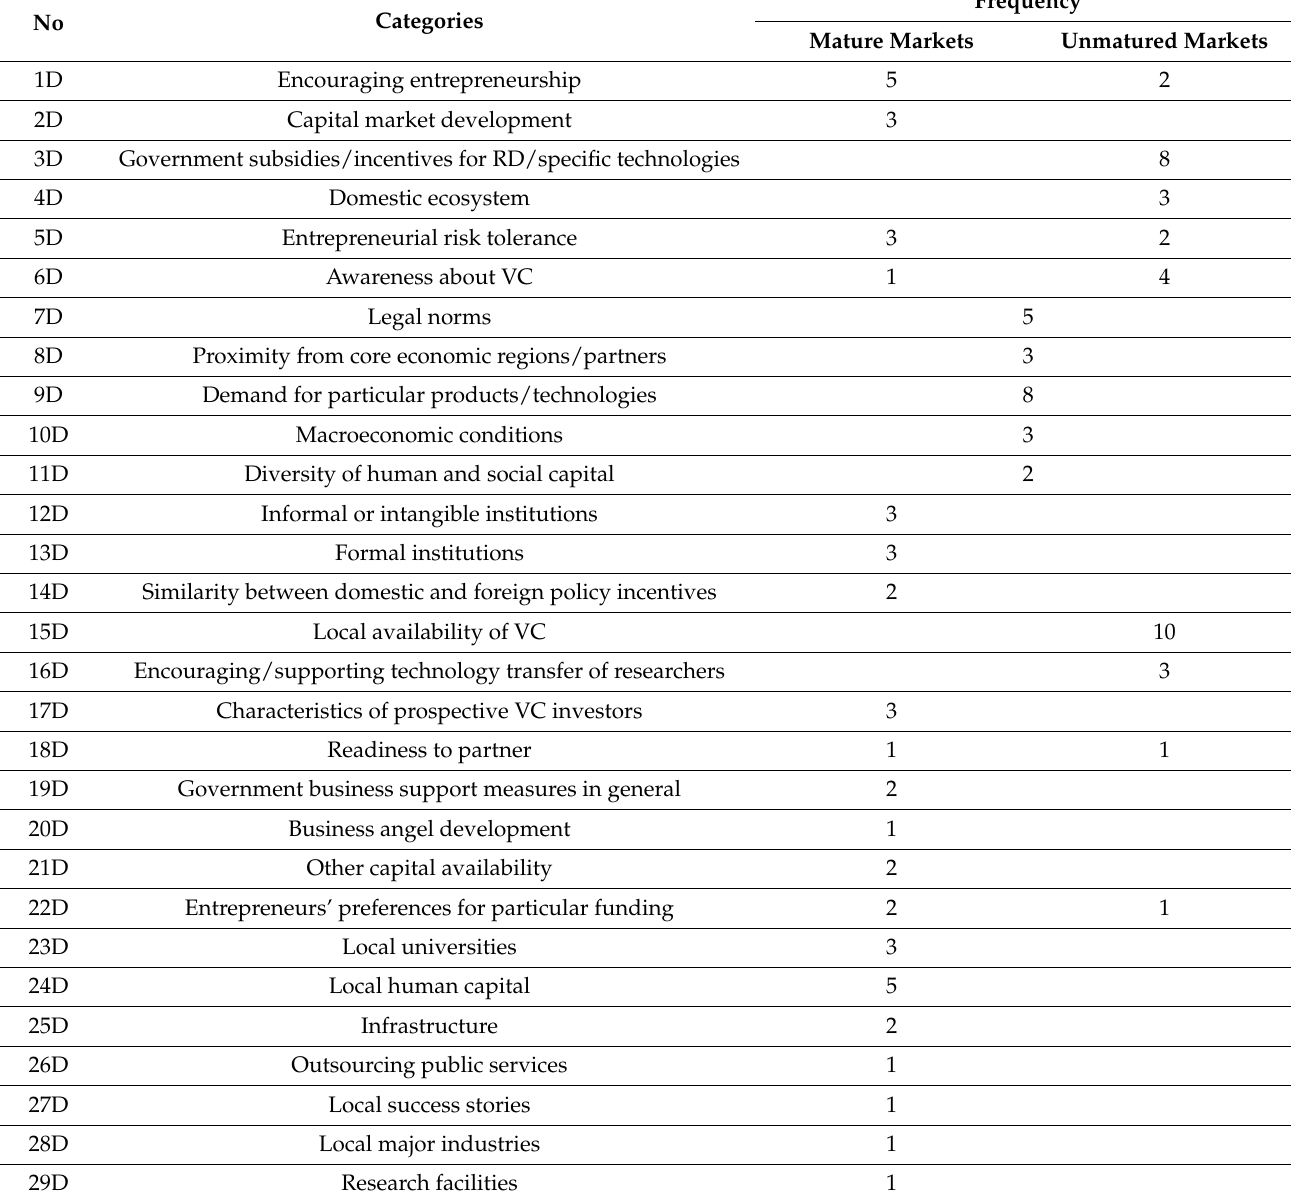
Table 5. The factors influencing VC